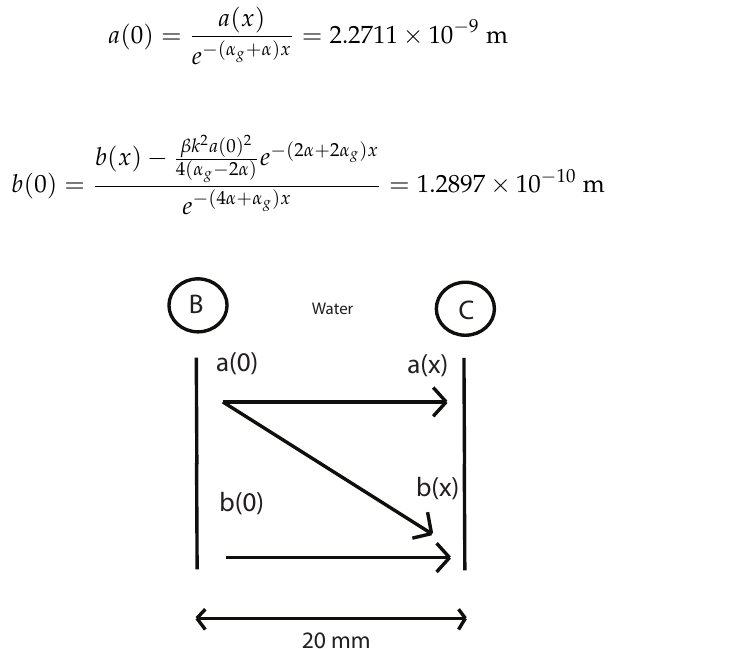
Figure 18. Determination of the fundamental and second harmonic in B by propagating this values from C to